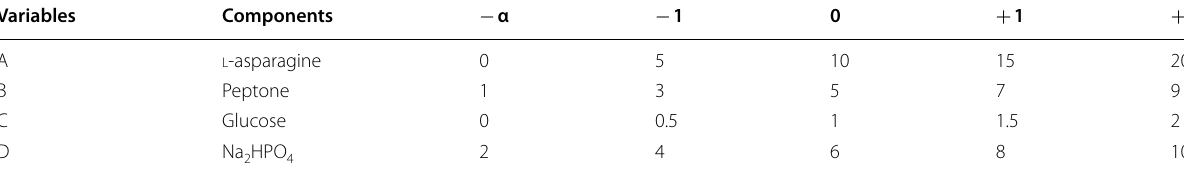
Table 3 Experimental range and levels of independent variables used for CCD